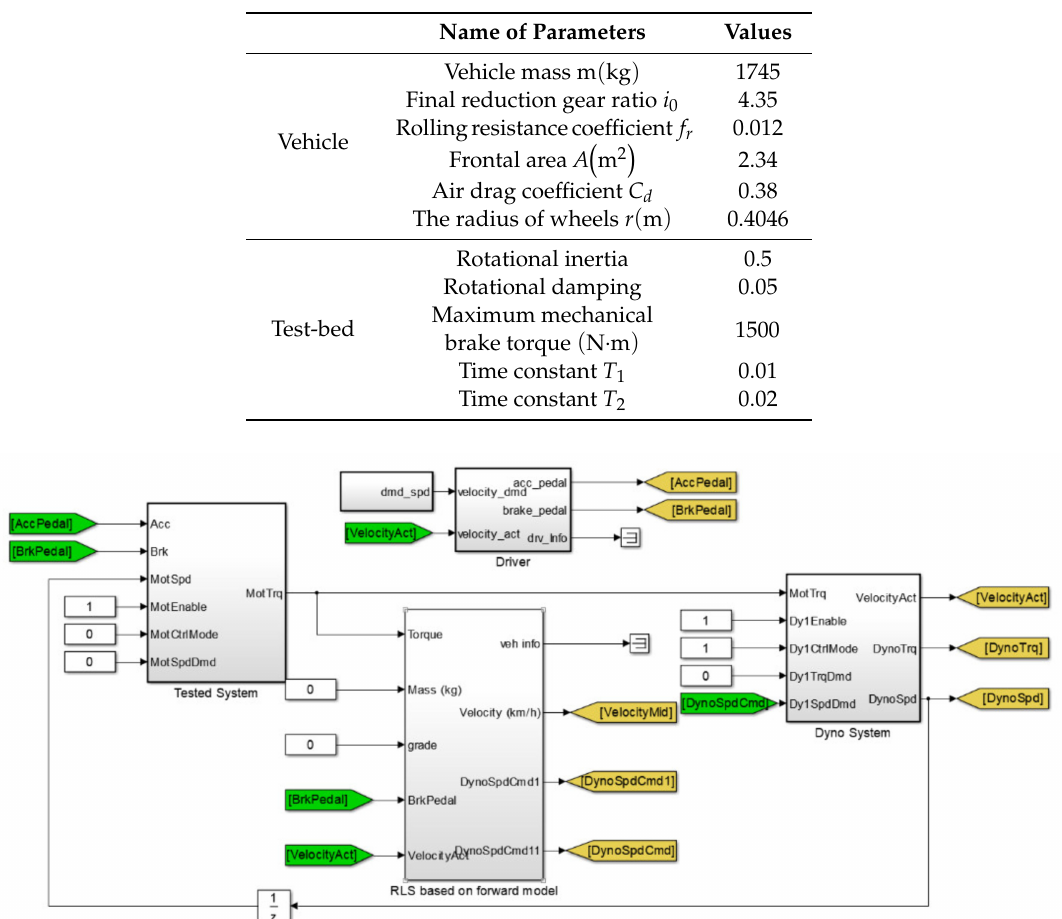
Table 1. Parameters of vehicle and test-bed.